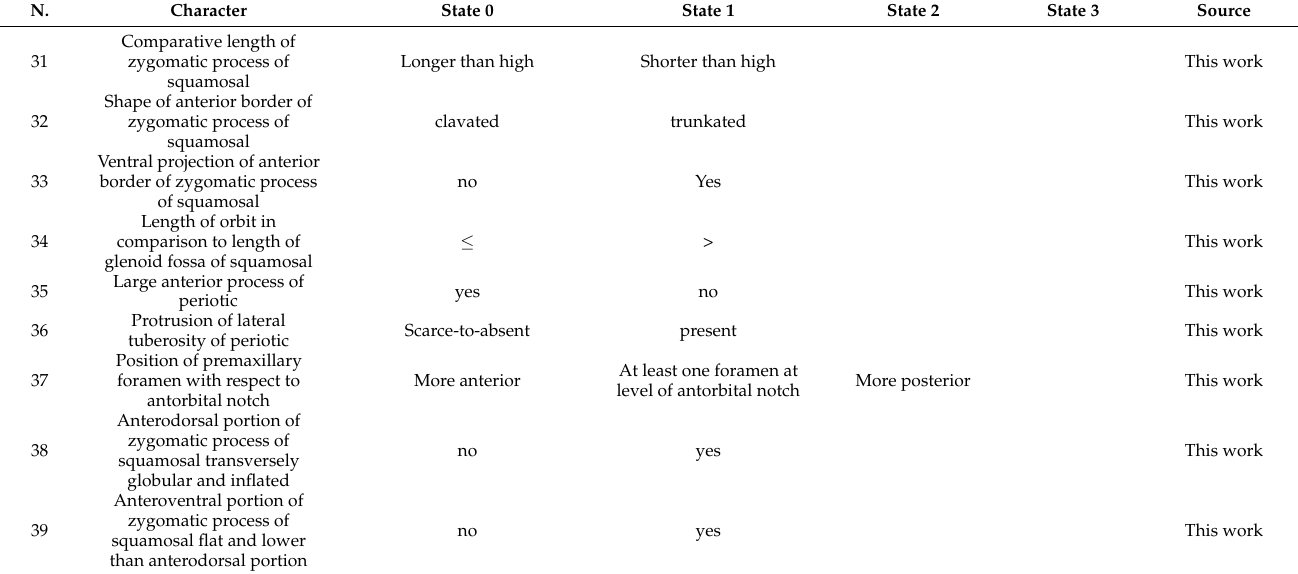
Table A2. Matrix used for phylogenetic and paleobiogeographic analyses. Note that the morphologi- cal dataset is included in characters 1–39. The last four characters (in light blue) represent occurrence data that were mapped onto the phylogenetic results and are not part of the morphological